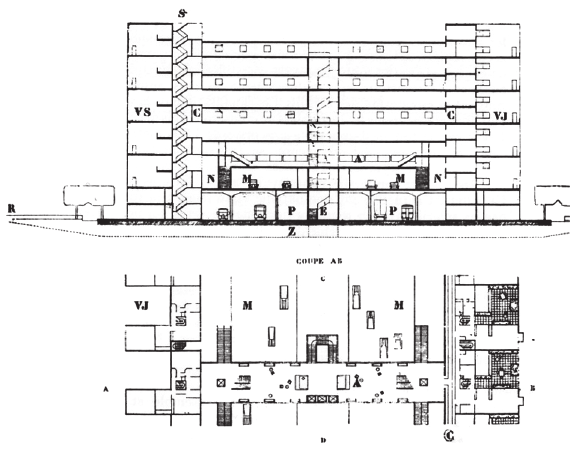
fig. 2. Cross section and detail of a ‘rue usine’ (flC